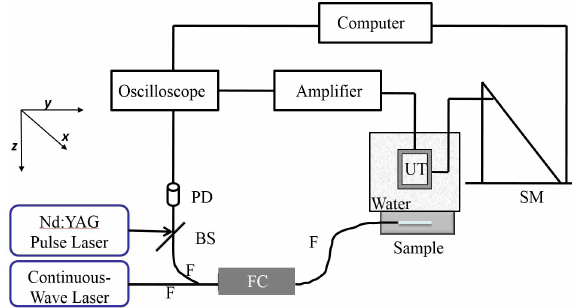
Fig. 1. Experimental setup. FC: Fiber coupler, F: Fiber, BS: Beam Splitter, PD: Photodiode, UT: focused ultrasound trans- ducer, SM: Stepper motor.